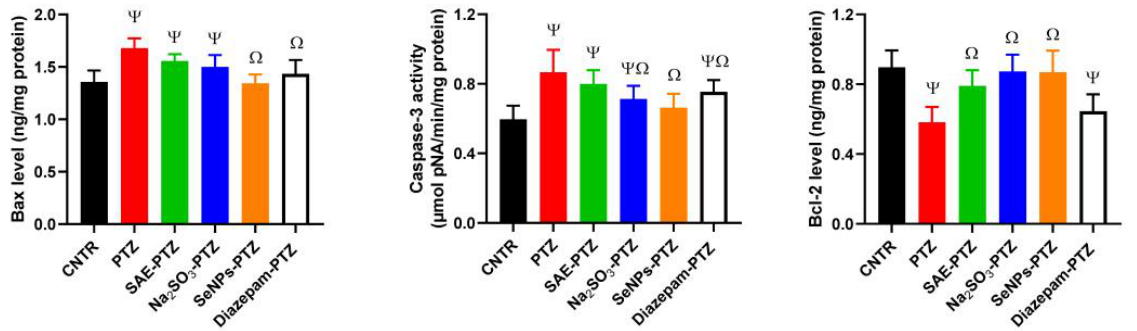
Figure 5. Anti-apoptotic effects of oral administration of Syzygium aromaticum extract (SAE), sodium selenite (Na 2 SeO 3 ), and green synthetized SeNPs using SAE (SAE-SeNPs), indicated by the cortical levels of pro-apoptotic Bax and caspase-3 activity, and anti-apoptotic Bcl-2, against pentylenetetrazol (PTZ)-induced neuronal cells apoptosis ( n = 8). Ψ and Ω indicate significant differences ( p < 0.05) compared with the control and PTZ-exposed groups, respectively. All values are presented as the mean ± standard deviation (SD).